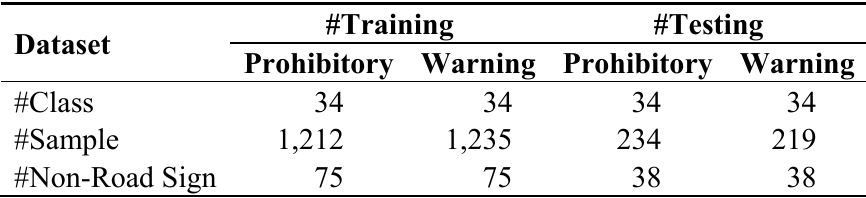
Table 4. The SVM classifier training and testing